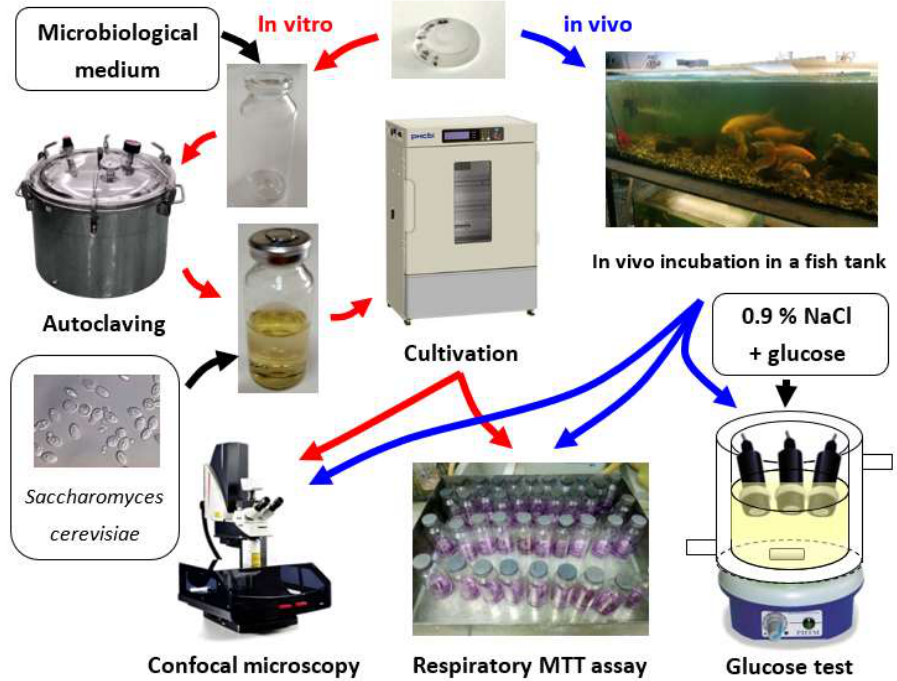
Figure 1. General scheme of experiments.